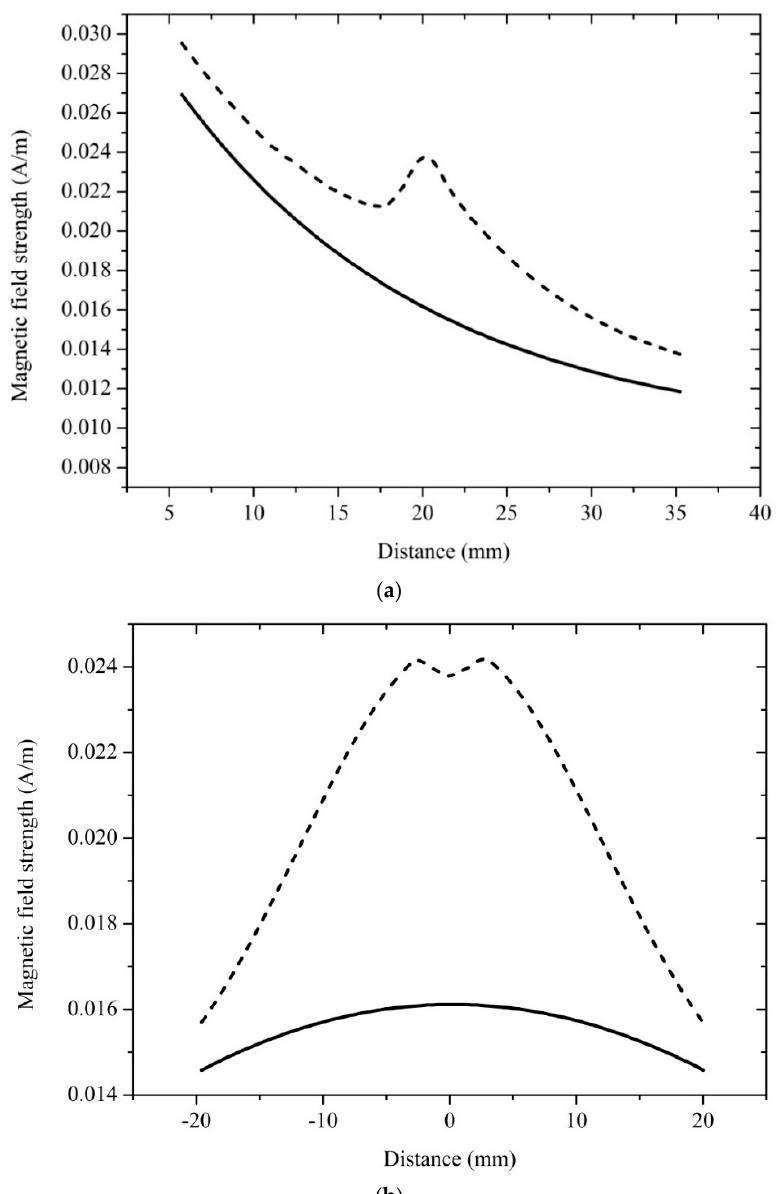
Figure 8. Simulation results of distribution of microwave magnetic field strength. The dash line represents the results with glass cell, and the solid line represents the results in free space. The simulation model was designed as the Figure 7a shows. Electromagnetic waves were radiated to the down at 9.19 GHz. The dimensions of the open-ended waveguide were 22.86 mm × 10.16 mm × 17 mm. We set the diameter of the column basal plane of glass cell to 20 mm, its height to 10 mm, and its thickness to 0.5 mm. The measurement distance was 52 mm. ( a ) The distribution of magnetic field strength in the direction of o-x (as the Figure 5c shows). Position 20 of horizontal axis was defined as the center of the glass cell at a measurement distance of 52 mm. The diameter of the column basal plane of the glass cell was 20 mm (10 to 30 mm). In the scope of 10 to 30 mm, magnetic field strength in the glass cell is larger than magnetic field strength in the free space. ( b ) Field strength in perpendicular direction to o-x (as the Figure 5c shows). Position 0 of horizontal axis was defined as the center of the glass cell at a measurement distance of 52 mm. The height of the glass cell was 10 mm ( − 5 to 5 mm). In the scope of − 5 to 5 mm, magnetic field strength in the glass cell is larger than magnetic field strength in the free space.